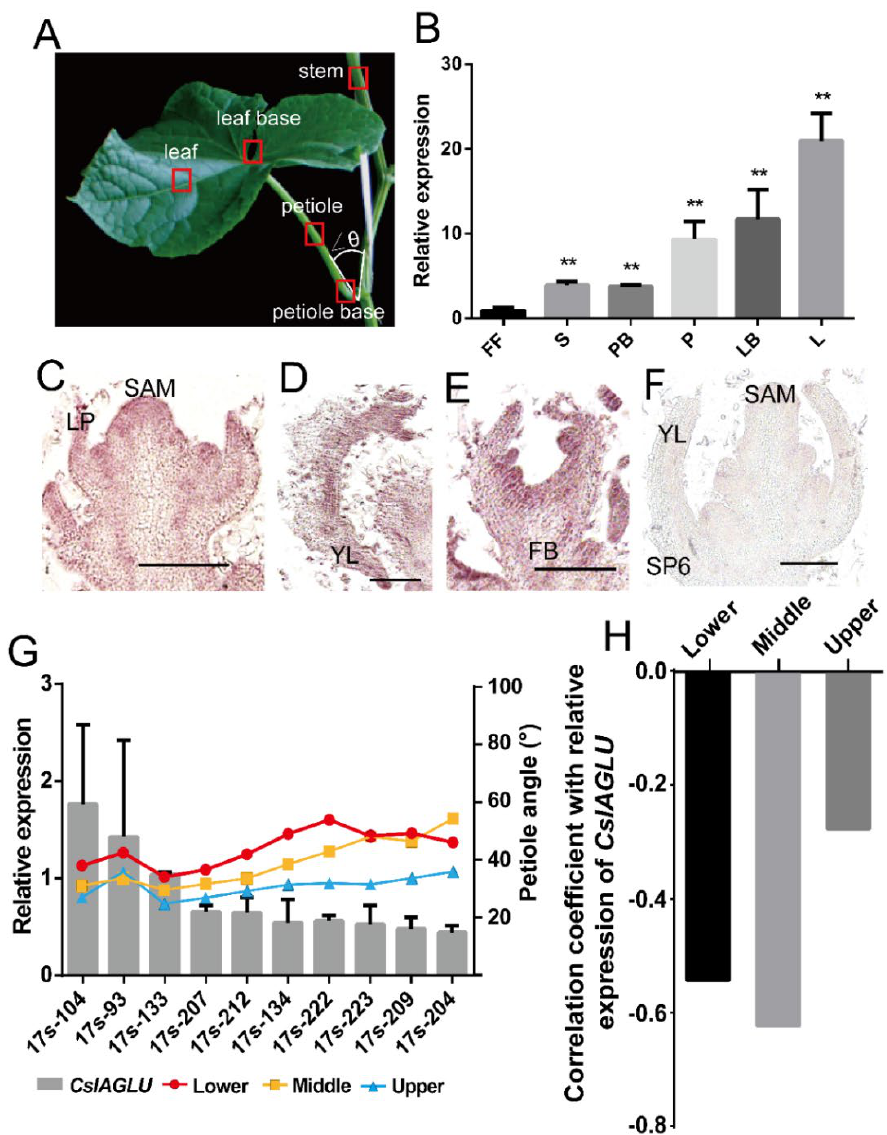
Figure 2. Correlation analysis of CsIAGLU expression and LPA in cucumber: ( A ) The image of a cucumber leaf. ∠ θ refers to the LPA. The red boxes refer to tissue samples used for expression analysis in ( B ). ( B ) qRT-PCR analysis of CsIAGLU in different tissues. FF, female flower; S, stem; PB, petiole base; P, petiole; LB, leaf base; L, leaf. CsIAGLU transcripts were quantified using CsUBI as the internal standard. A significance analysis compared to FF was performed with the two-tailed Student’s t -test (** p < 0.01). Values are means ± SDs ( n = 3). ( C – F ) In situ hybridization analysis of CsIAGLU : shoot apex ( C ), young leaf ( D ) and floral bud ( E ). The sense CsIAGLU probe was hybridized as a negative control ( F ). Scale bar, 1 µ m. ( G ) Expression of CsIAGLU in different cucumber lines with various LPAs. The gray columns represent the expression of CsIAGLU , and the line charts represent the LPAs in lower, middle and upper parts. Values are means ± SDs ( n = 3). ( H ) Correlation analysis between CsIAGLU expression and